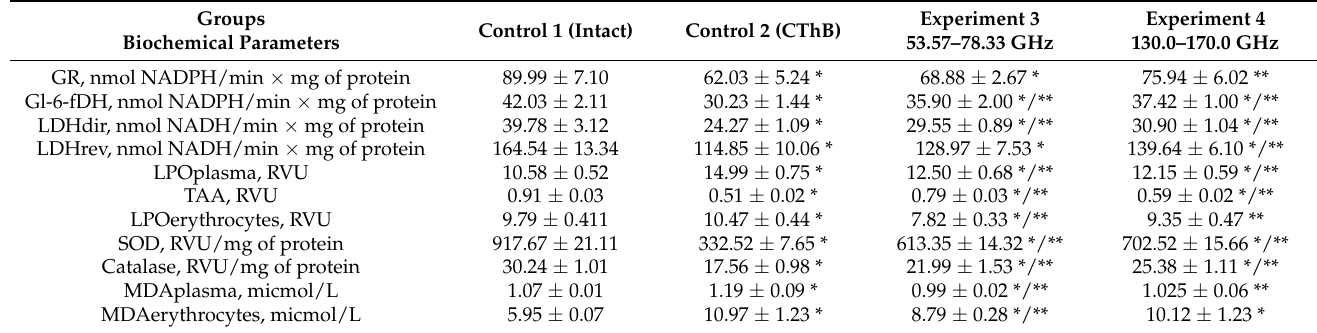
Table 1. Dynamics of indicators of antioxidant and energy systems in groups. Groups Biochemical